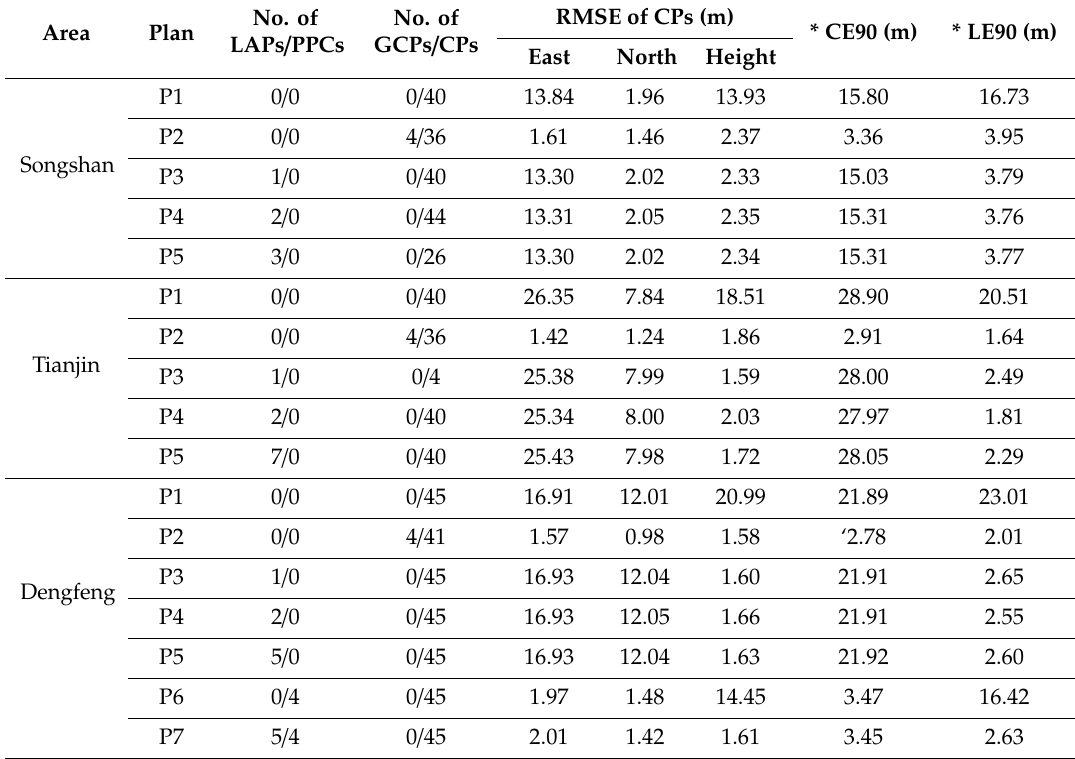
Table 4. Accuracy statistics for the proposed combined adjustment under di ff erent types of points’ (CPs, GCPs, LAPs) distribution in the Songshan, Dengfeng, and Tianjin areas. Area Plan